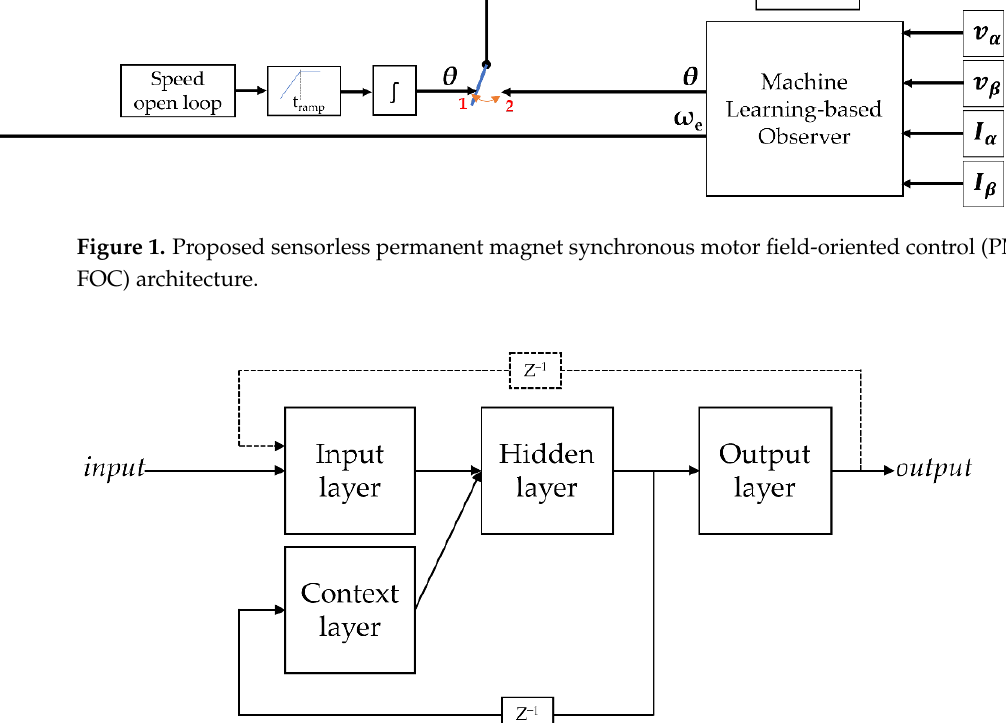
Figure 2. Modified Elman neural network (ENN) block diagram.